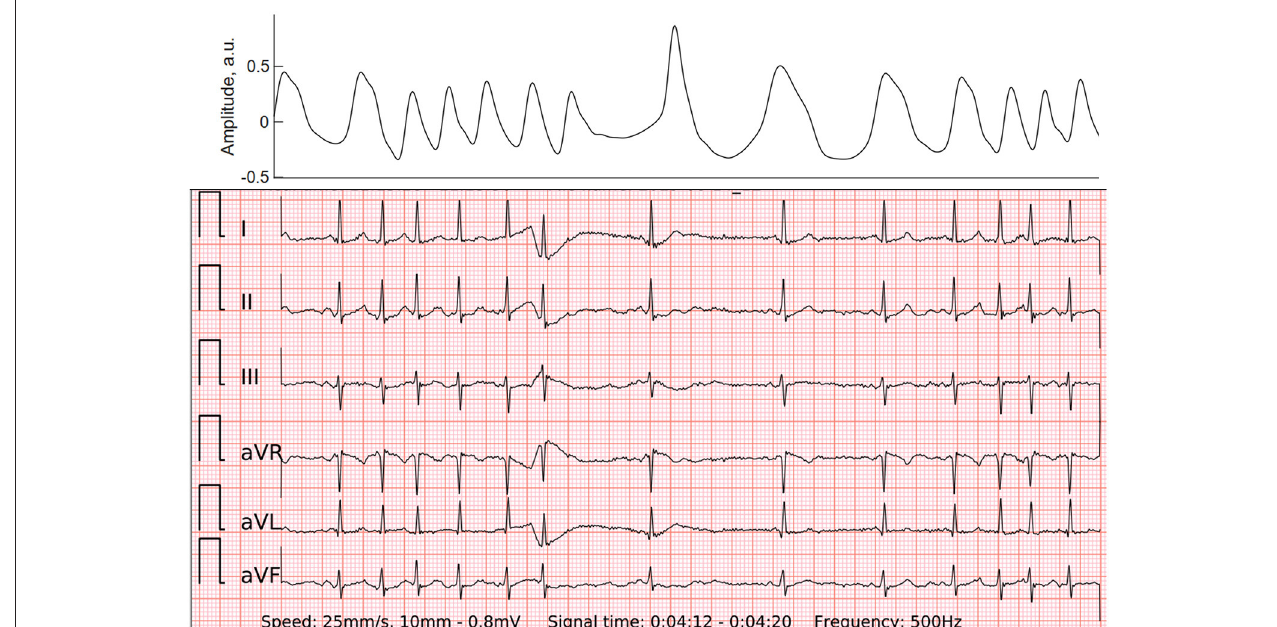
FIGURE 4 | PPG (top panel) and wearable 6-lead ECG (lower panel) of the atrial run, which may also be called “micro-AF”. By definition, it is a sudden onset of irregular tachycardia with episodes of ≥ 5 consecutive supraventricular beats and total absence of P-waves, lasting less than 30s (16).